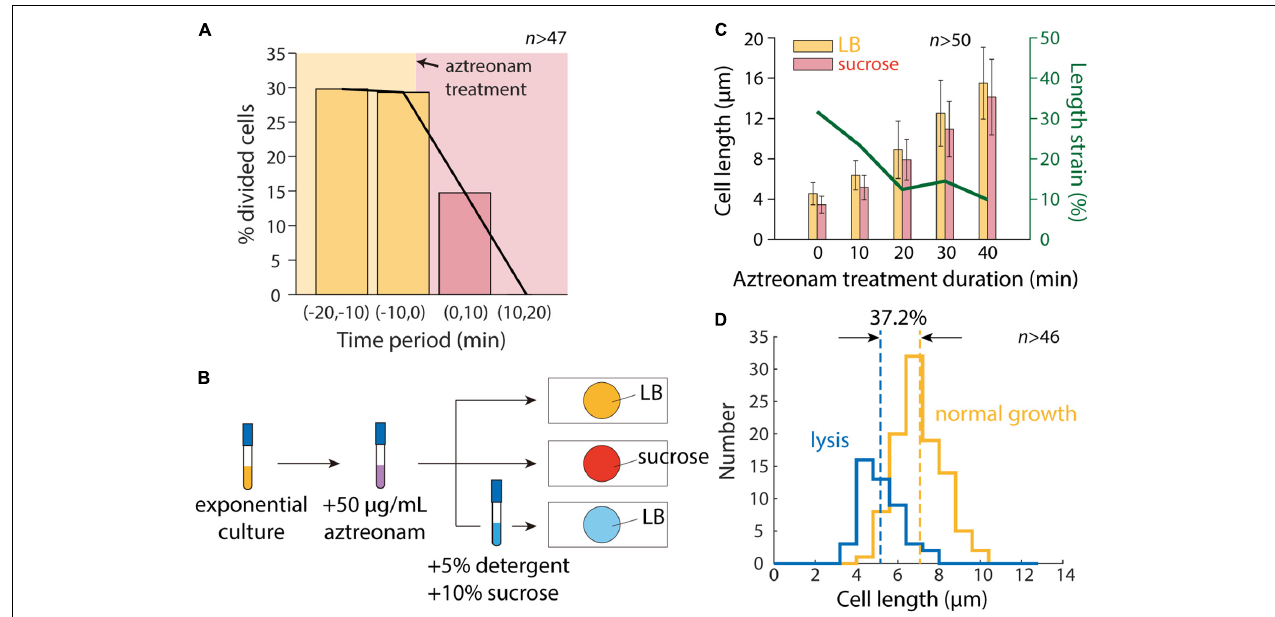
FIGURE 3 | Inhibition of cell division allows for accurate measurement of length contraction after hyperosmotic shock. (A) During time-lapse imaging of E. coli cells treated with 50 µ g/mL aztreonam, cell division was fully inhibited within 20 min. (B) Schematic of modified protocol for agarose pad-based measurements of cell envelope stiffness, in which cells are treated with 50 µ g/mL aztreonam for various amounts of time before imaging on agarose pads. (C) Mean length of cells grown in a test tube with 50 µ g/mL aztreonam increased with the duration of treatment, due to the inhibition of cell division. After a hyperosmotic shock on an agarose pad with LB+20% sucrose, the measured length strain gradually decreased with the duration of treatment and plateaued at ∼ 10%, consistent with microfluidic device measurements ( Figure 1D ). (D) After detergent treatment, the population-averaged length of aztreonam-treated cells was lower by an amount corresponding to a strain of 37.2%, consistent with microfluidic device measurements ( Figure 1D